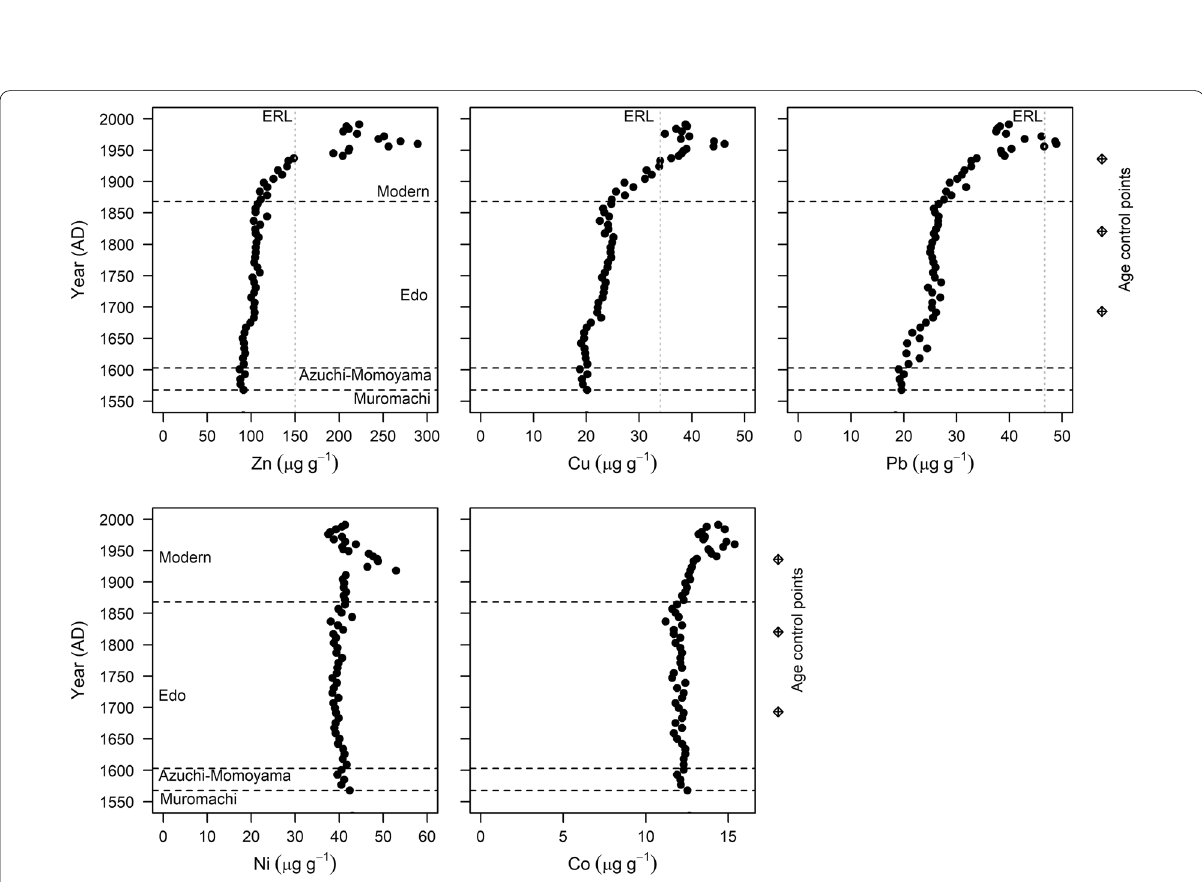
Fig. 5 Trace metal concentrations of the bulk sediment in the piston core during the last 450 years. The horizontal dashed lines indicate the Japanese periods. The vertical dotted lines mark the ERL (effect range—low) values (Long et al.